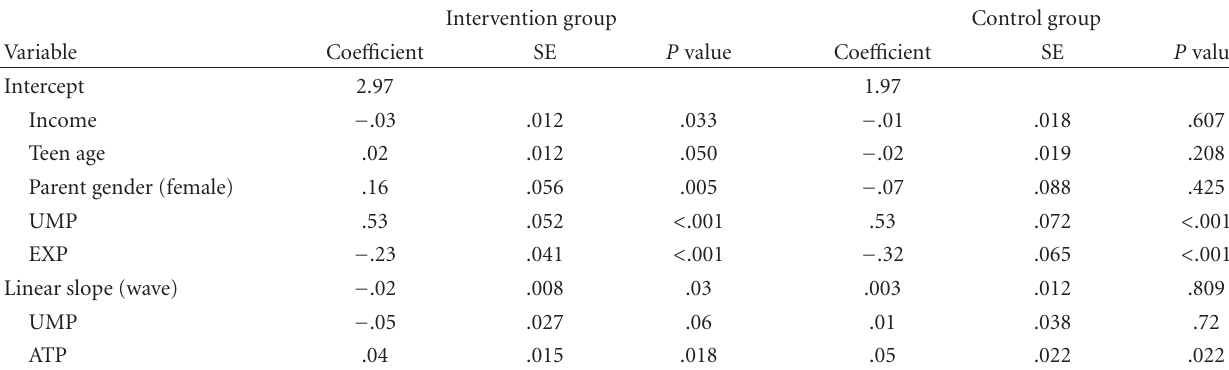
Table 3: Hierarchical linear growth model for parent-reported open communication.